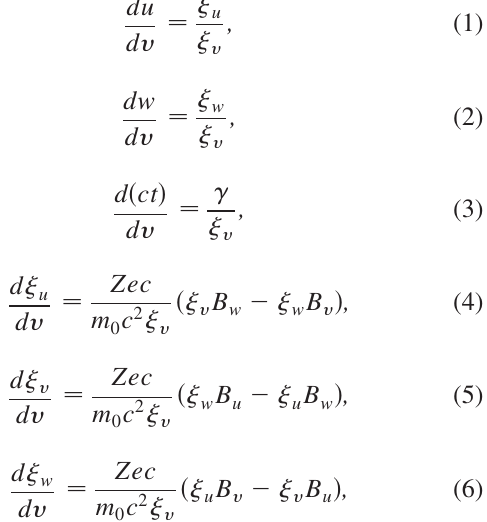
ffiffiffiffiffiffiffi p (cid:3)"